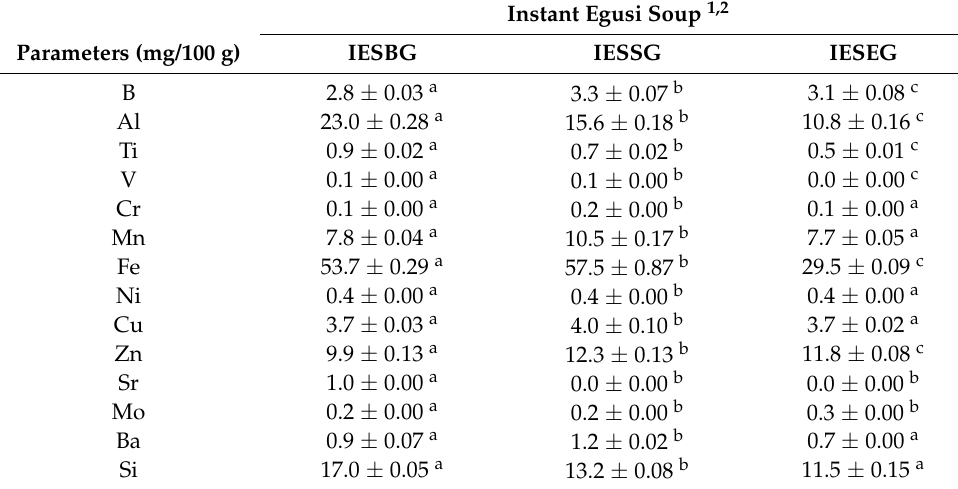
Table 6. Trace mineral composition of instant egusi